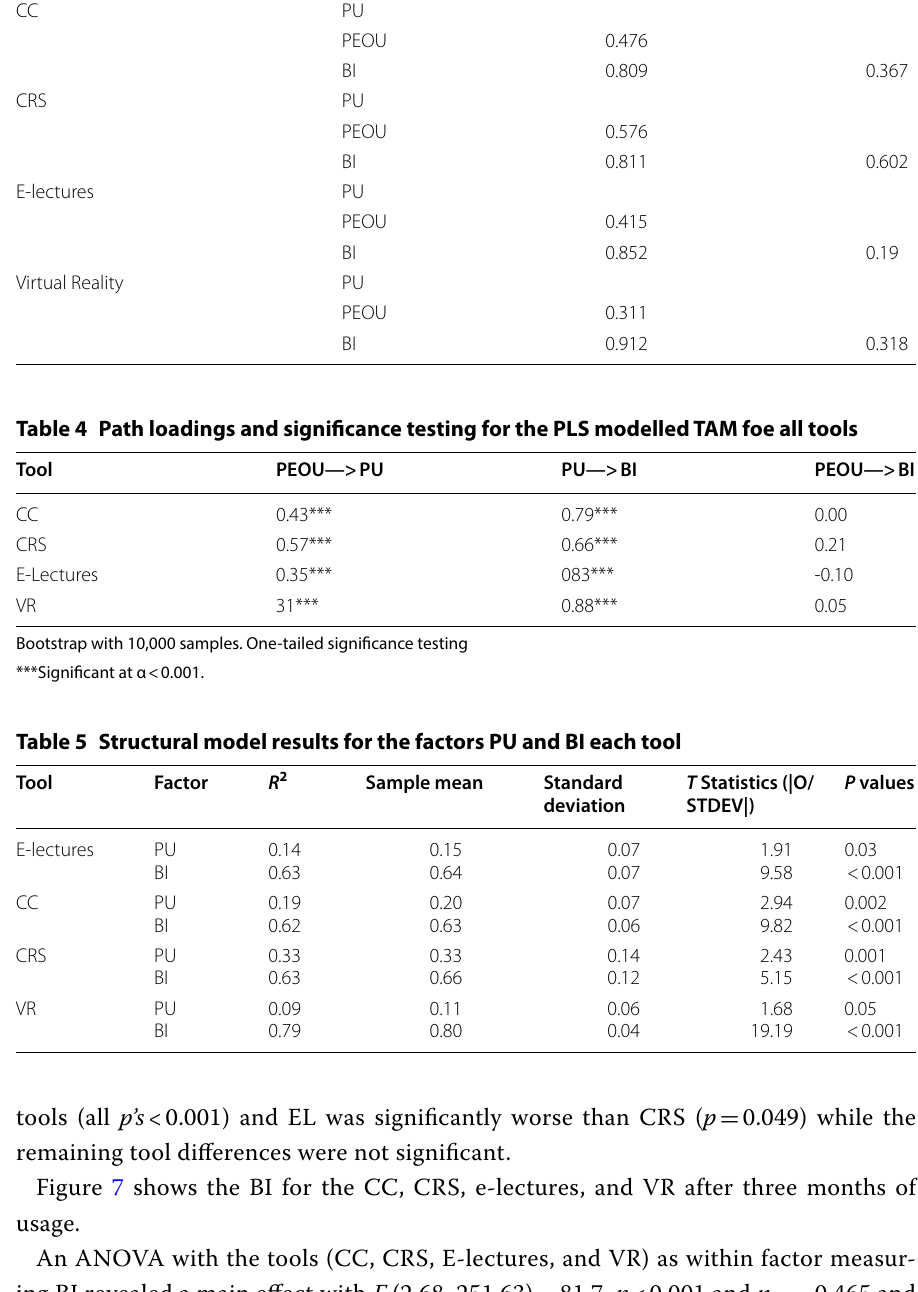
Table 3 Discriminant validity matrix for the heterotrait-monotrait ratio of correlations for perceived usefulness (PU), perceived ease of use (PEOU), and behavioral intention (BI) Tool